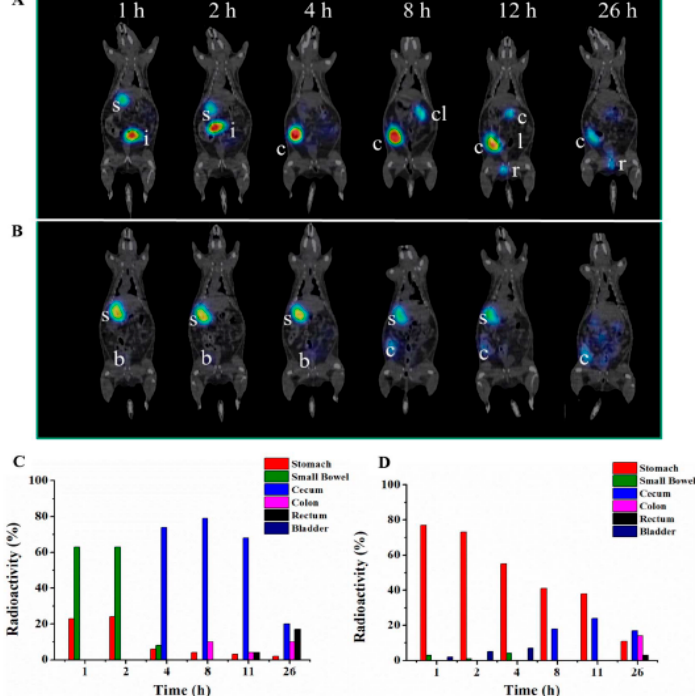
Figure 6. Oral biodistribution of 99m Tc-enveloped nanocomplexes (ENCPs) and 99m Tc pertechnetate (control) at 1, 2, 4, 8, 11, and 26 h using SPECT/CT imaging ( A , B ) and gamma counting ( C , D ) in Wistar rats (s = stomach, i = intestine, c = cecum, cl = colon, r = rectum, b = bladder). Reprinted with permission from Niu et al. (2018) [107].